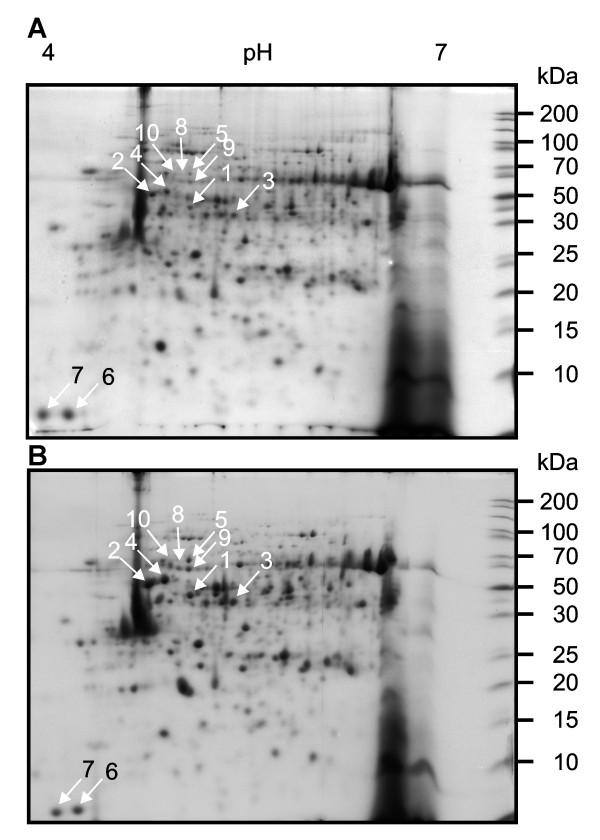
2-DE analysis of citrus leaves proteins induced by XacPNP. Protein profiles in 2-DE SDS-PAGE of urea-buffer extracted total soluble proteins of citrus leaves stained with Coomassie blue. Equal amounts of proteins (150 μg) were separated on 7 cm pI 4-7 linear gradient strips in the first dimension and on 12% SDS-PAGE in the second dimension. (A) citrus leaves infiltrated with Tris 50 mM solution as control; (B) citrus leaves infiltrated with 5 μM XacPNP. Proteins with significantly different expression levels between control and infected plants (p < 0.05) are indicated with white arrows and numbered. Numbers refer to protein spot numbers on Table 1. Numbers on the right indicate molecular mass in kilodalton (kDa).